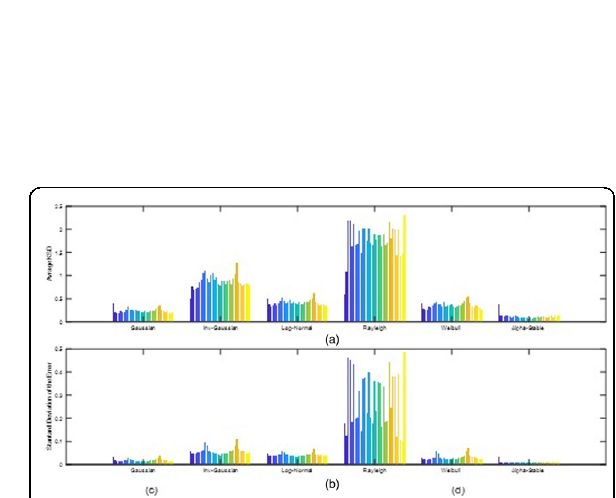
Fig. 19 Estimation results for KTH database images. a Average KSD value for different distributions in each subband. b Standard deviation of the error